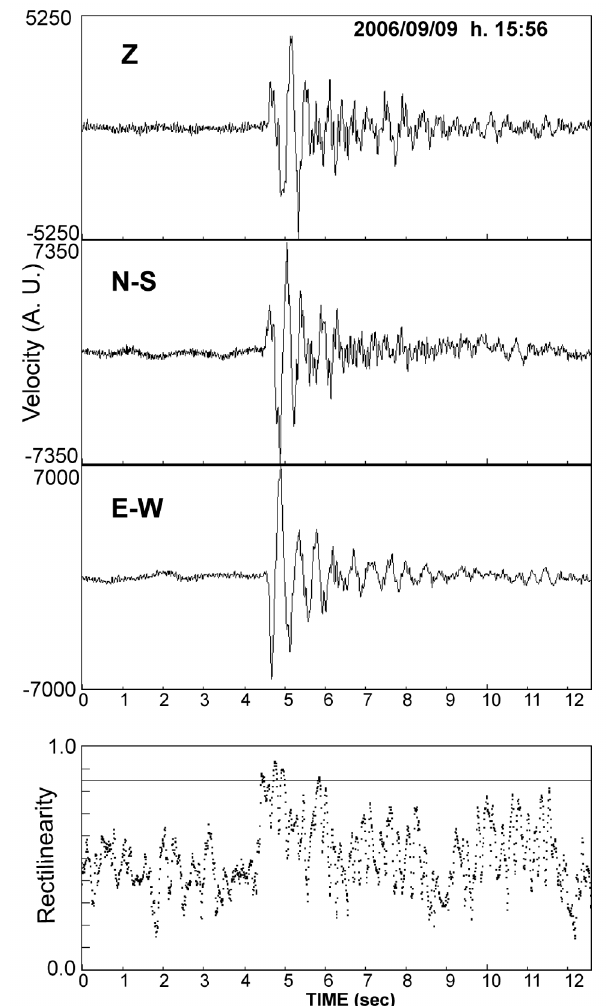
Fig. 3. Example of three component waveforms recorded at STZ2 (Event n. 13 in tab. I) and calculated tempo- ral trend of the